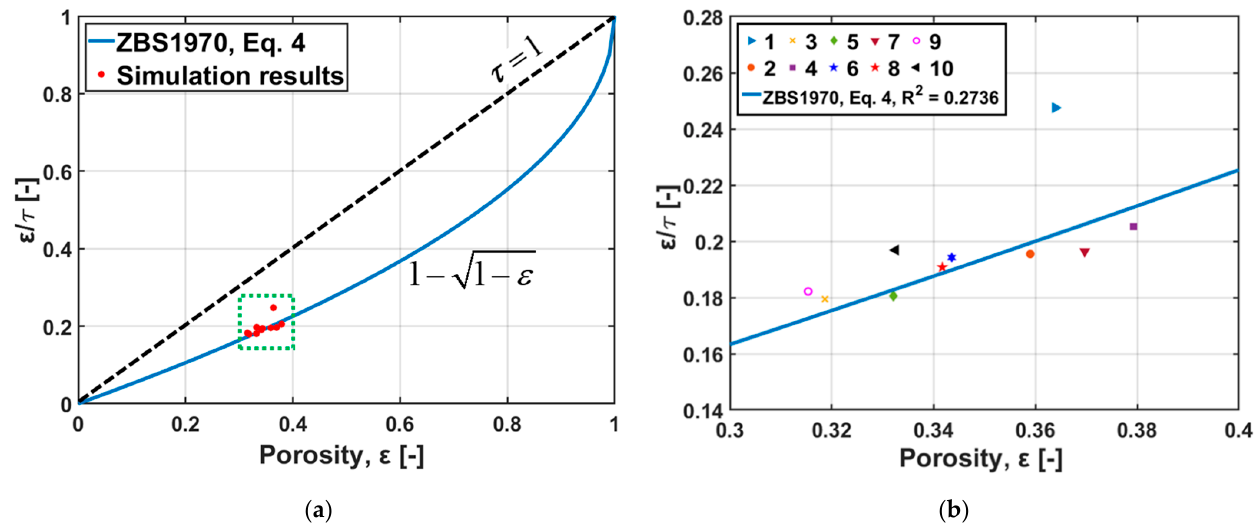
Figure 7. ( a ) Comparison of residual conductivity results with the ZBS model, Equation (4). ( b ) Expanded region of interest shown in green lines in ( a ).